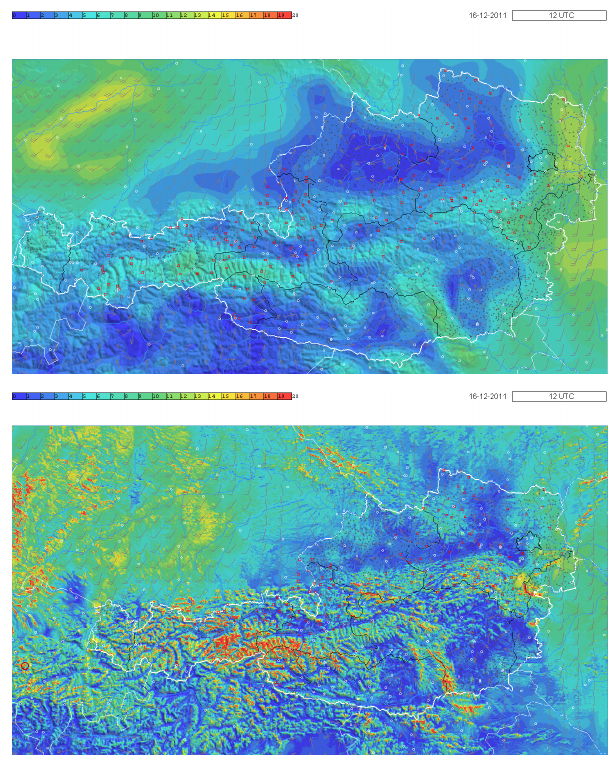
Figure 1. Example of a 10-m wind analysis provided by the INCA wind module issued for 16 December 2011, 12:00UTC (bottom). The top figure shows the corresponding first guess field taken from the ALADIN-AUSTRIA model run initialized at 16 December 2011 00:00 UTC, +12 hours forecast.